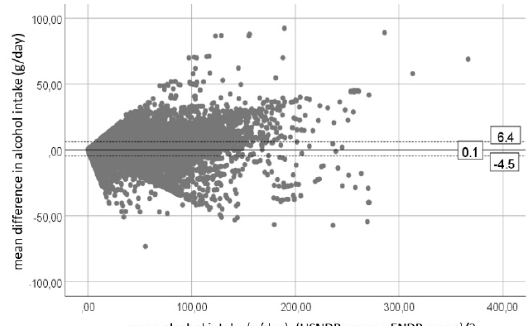
Figure 2. Bland-Altman plots for the dietary questionnaire (DQ) data representing the mean differences and their limits of agreement for energy, total fat, proteins, carbohydrates and alcohol intakes between the U.S. nutrient database (USNDB) and the EPIC nutrient database (ENDB). The mean difference is represented by the full line, the upper and lower limit of agreement are presented by dotted lines.